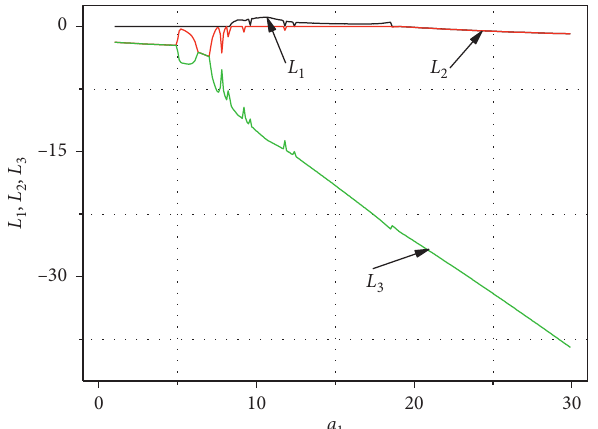
Figure 2: L a � 2, and a 4